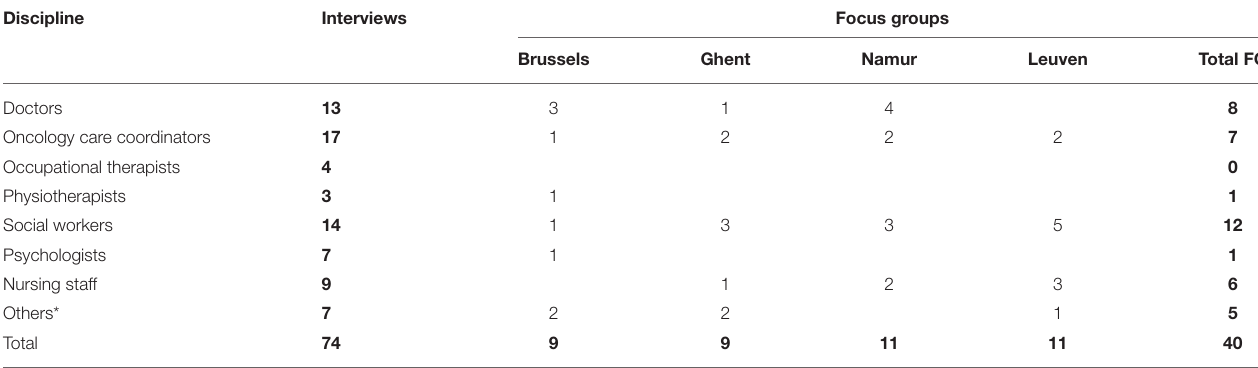
TABLE 1 | Number of participants in semi-structured interviews and focus groups by discipline (ordered by location of the focus-group discussion).